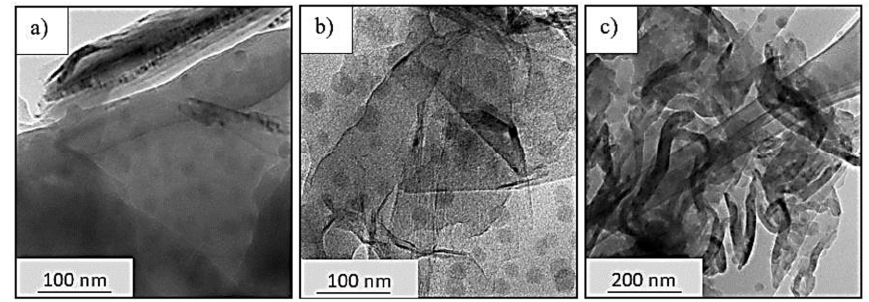
Figure 1. TEM Images of 0.2 wt% GNP in ( a ) 5 wt% NS, ( b ) 15 wt% NS, and ( c ) 25 wt%